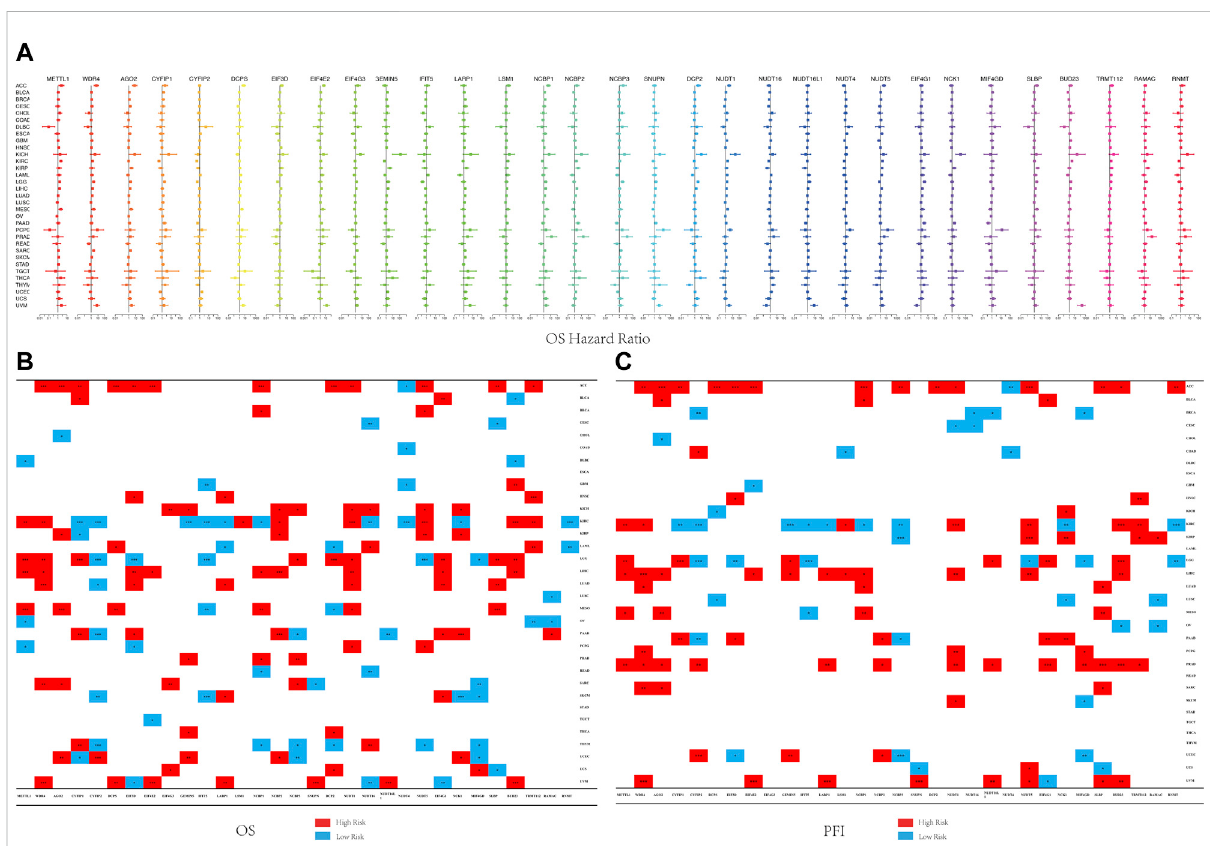
FIGURE 2 Forest map and survival analysis of m7G regulators in multiple cancers. (A) The forest map showing the overall survival risk ratio of 31 m6A- related genes across 33 TCGA cancer types. (B) Analysis of the correlation of m7G-related regulators with OS across multiple cancer types. (C) Analysis of the correlation of m7G-related regulators with PFI across multiple cancer types (* p < 0.05,** p < 0.01, and *** p <